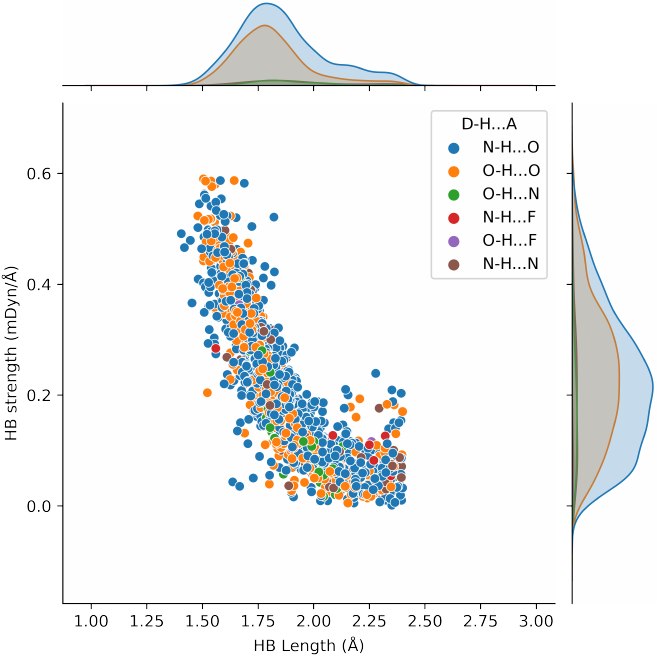
Figure 6. Relationship between hydrogen bond strength and length in database B. Hydrogen bond types describe by the colored points as D-H · · · A, where D is the hydrogen bond donor, and A is the hydrogen bond acceptor. Database B comprised of ca. 400 experimental protein–ligand complexes and ca. 2200 protein–ligand hydrogen bonds with their geometries and strengths. Experimental PDB IDs for database B can be found in the Supplementary Materials under the topic of PDB IDs for database